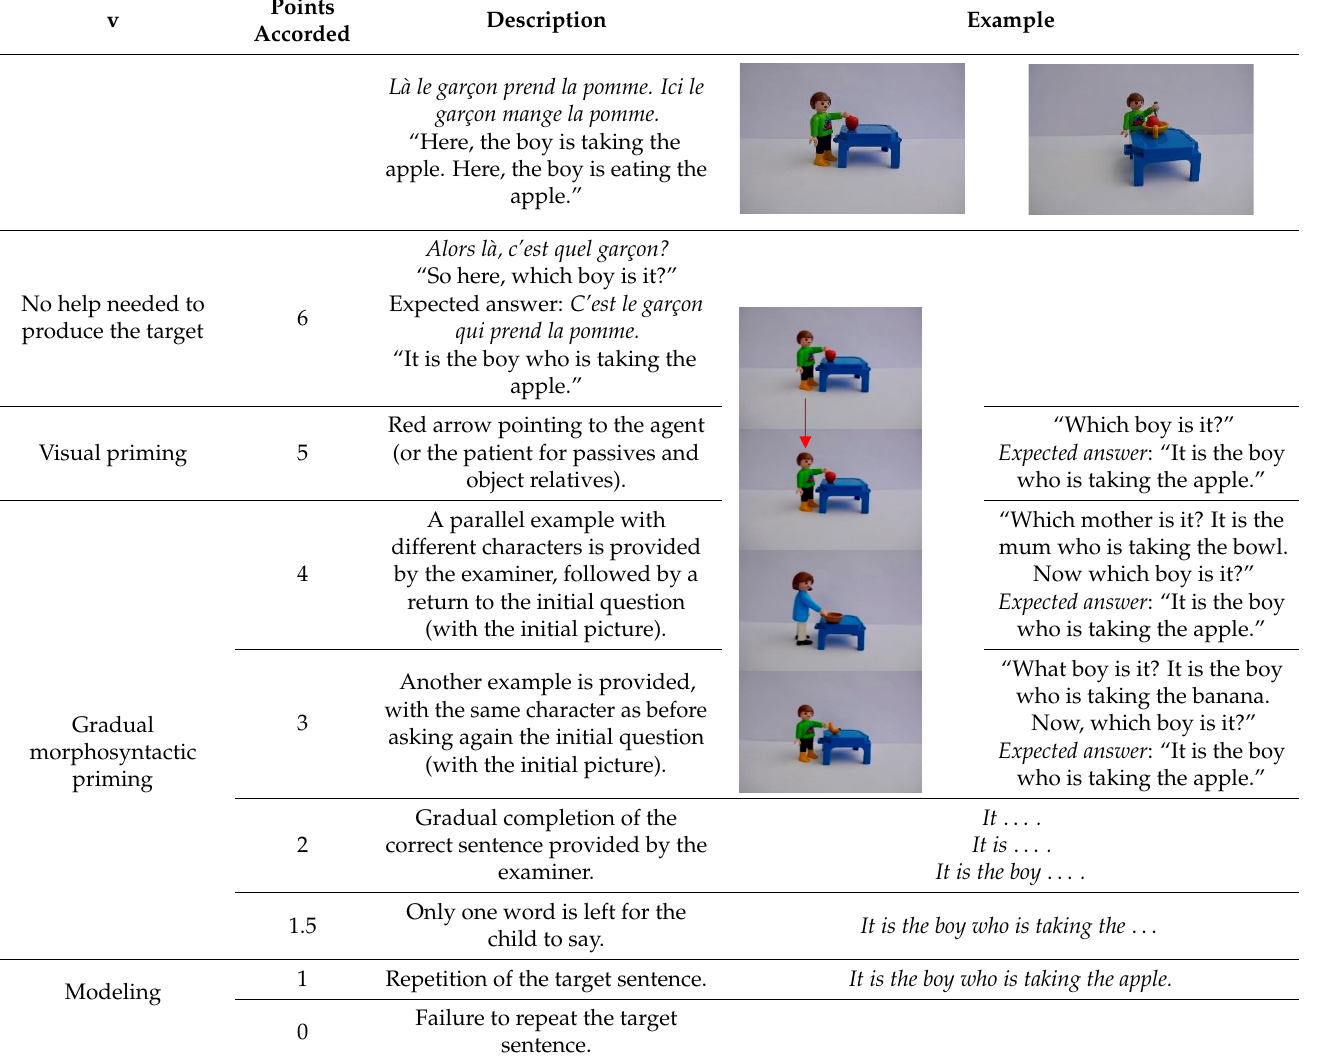
Table 3. An example of graduated prompts and scoring for a subject